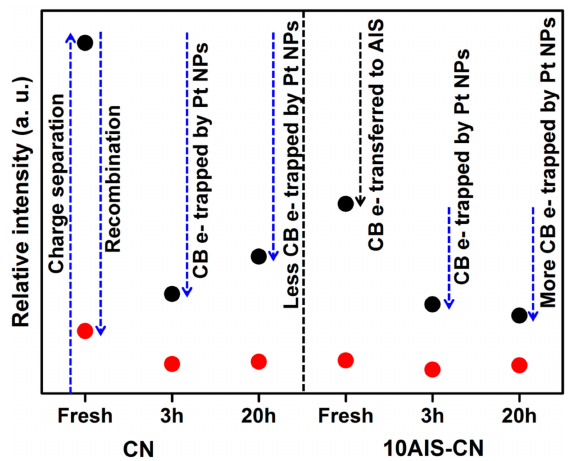
Figure 6. Intensity (double integral) of the CB-e-EPR signal (initial background signal in the dark substracted) during UV-vis light irradiation (black dots) and after light switched-off (red dots). Values for as-prepared samples without Pt (fresh) taken from Figure 5b.